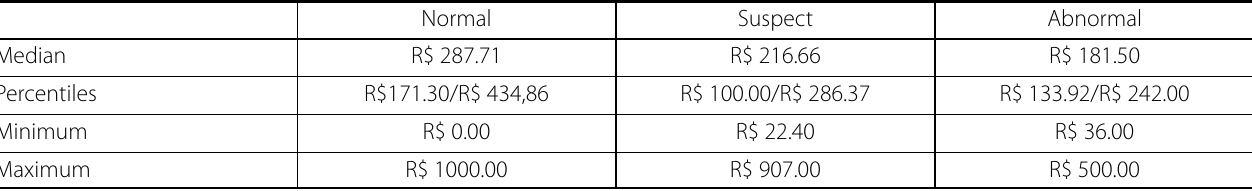
Table 5. Relation between income per capita and income for the Denver II * (n =